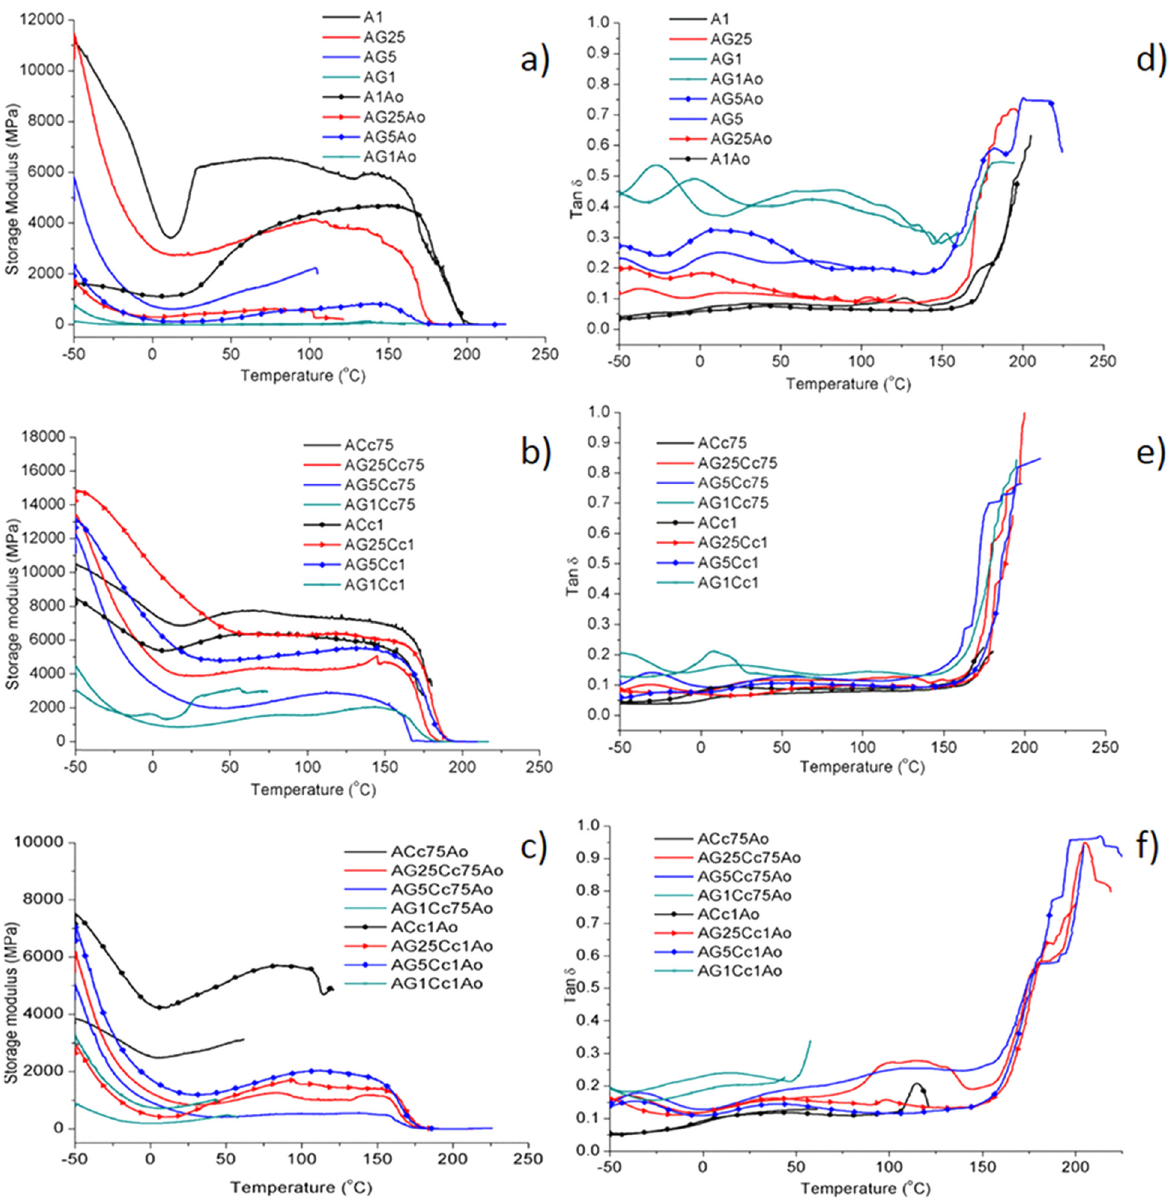
Figure 1: Dynamic mechanical properties, storage modulus of bio fi lms: ( a ) none cross - linked and added with glycerol, without and with oleic acid; ( b ) cross - linked and added with glycerol; and ( c ) cross - linked and added with glycerol and oleic acid and tan δ of ( d ) none cross - linked and added with glycerol, without and with oleic acid; ( e ) cross - linked and added with glycerol; and ( f ) cross - linked and added with glycerol and oleic